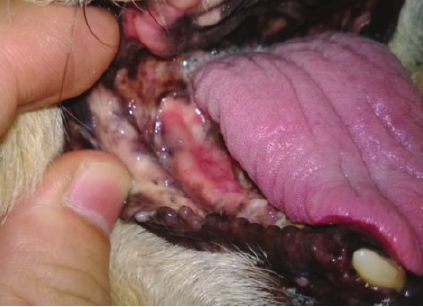
Figure 4: Picture taken 45 days after the ECT treatment. A complete response was